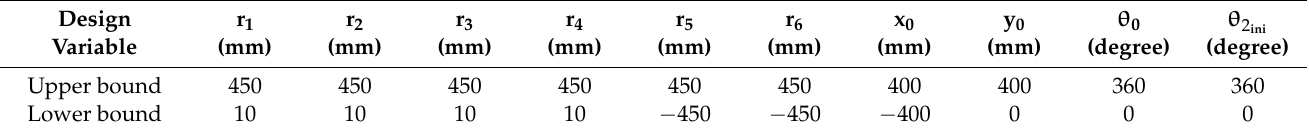
Table 2. Limits of design